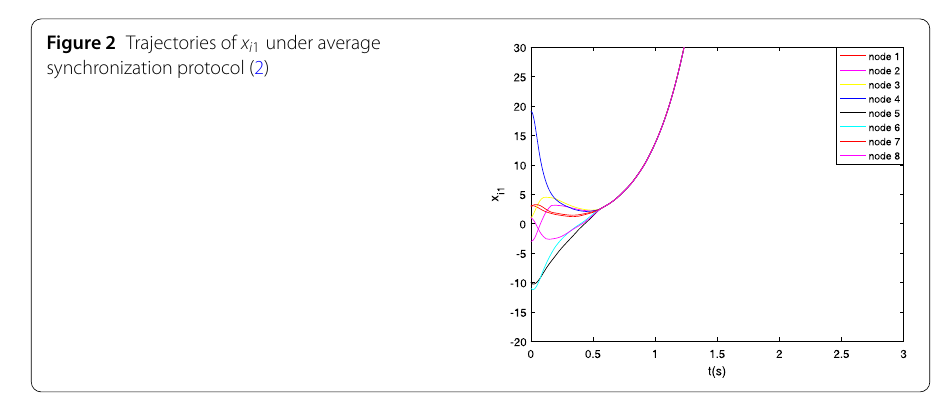
Figure 3 Trajectories of x i 2 under average synchronization protocol